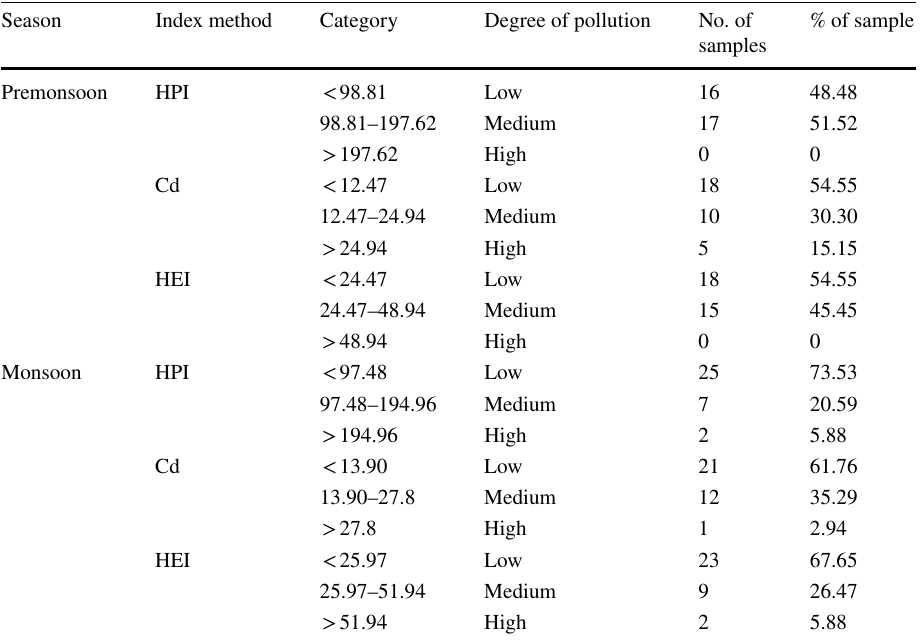
rating based on mean-based reclassification methods including HPI, Cd, and HEI in Premonsoon and Monsoon